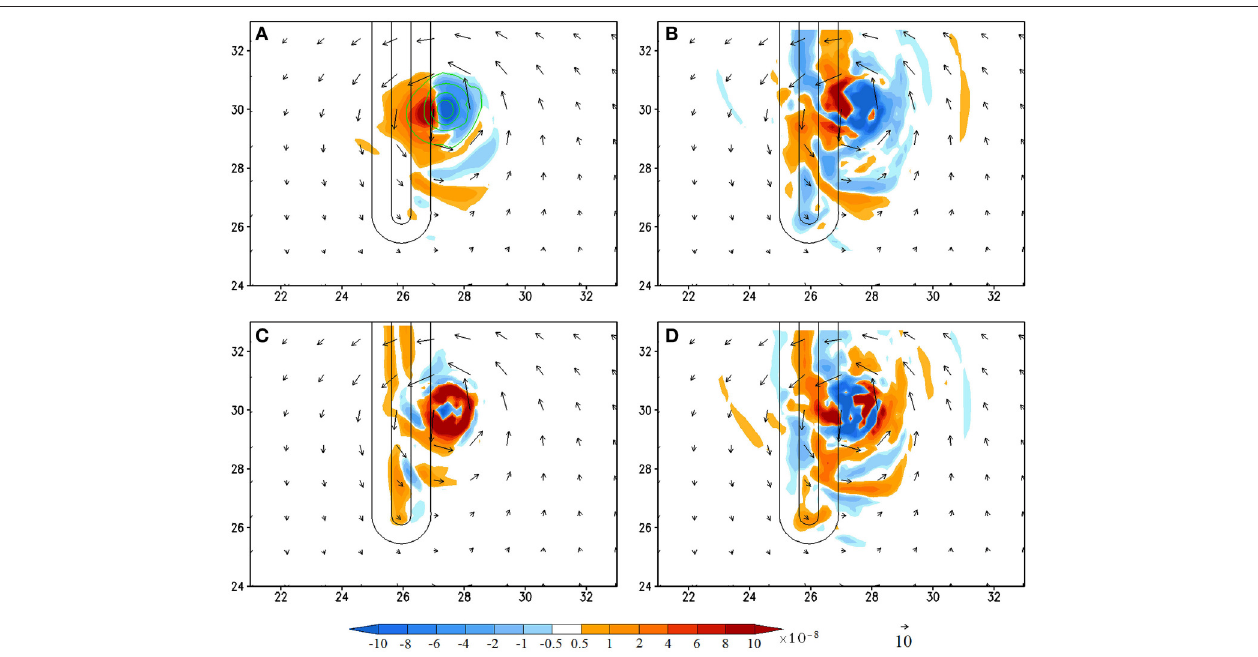
FIGURE 5 | (CNTL/A2) Vorticity budget analysis averaged for the 950–500 hPa layer at 168h (shaded): (A), vorticity tendency (VT); (B), horizontal vorticity advection; (C), relative vorticity stretching, and (D), residual term. The vertical vorticity field is depicted by contours (0.0001, 0.0005, 0.001, 0.002,